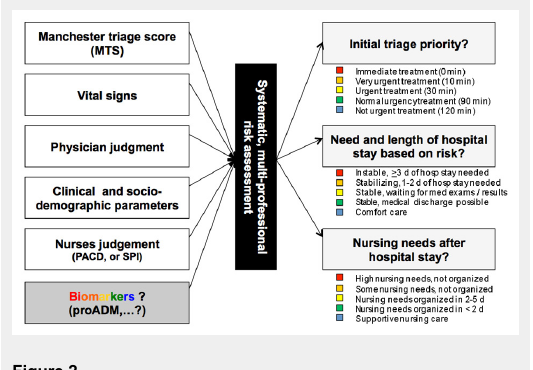
Systemic multiprofessional risk assessment for improve patient management adapted from [261]. ProADM = proadrenomedullin